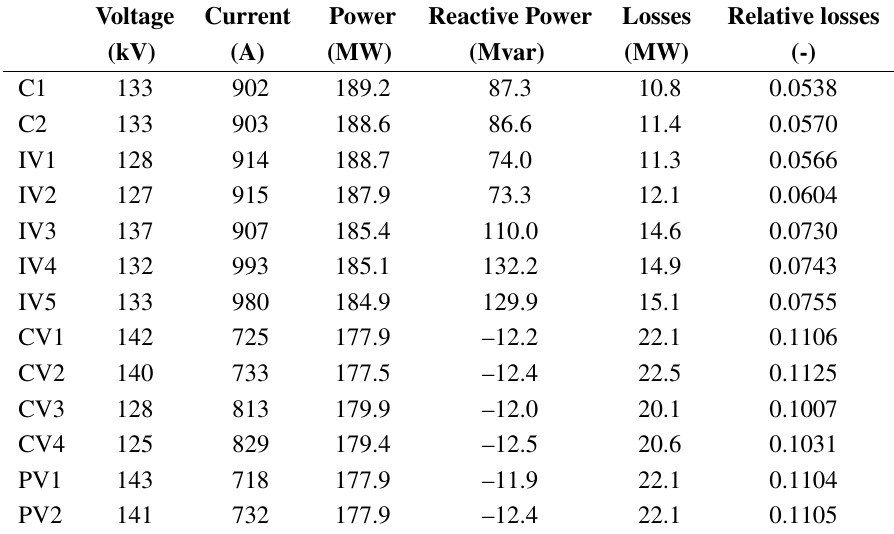
Table 3 . Electrical parameters at the connection to the HV grid at rated power of 13 electrical systems for 200 MW wind farm with a 100 km connection to shore Voltage Current Power Reactive